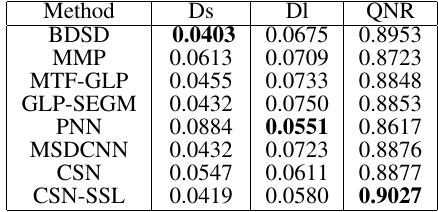
Table 2. Objective performance of the pan-sharpening methods on full-resolution test